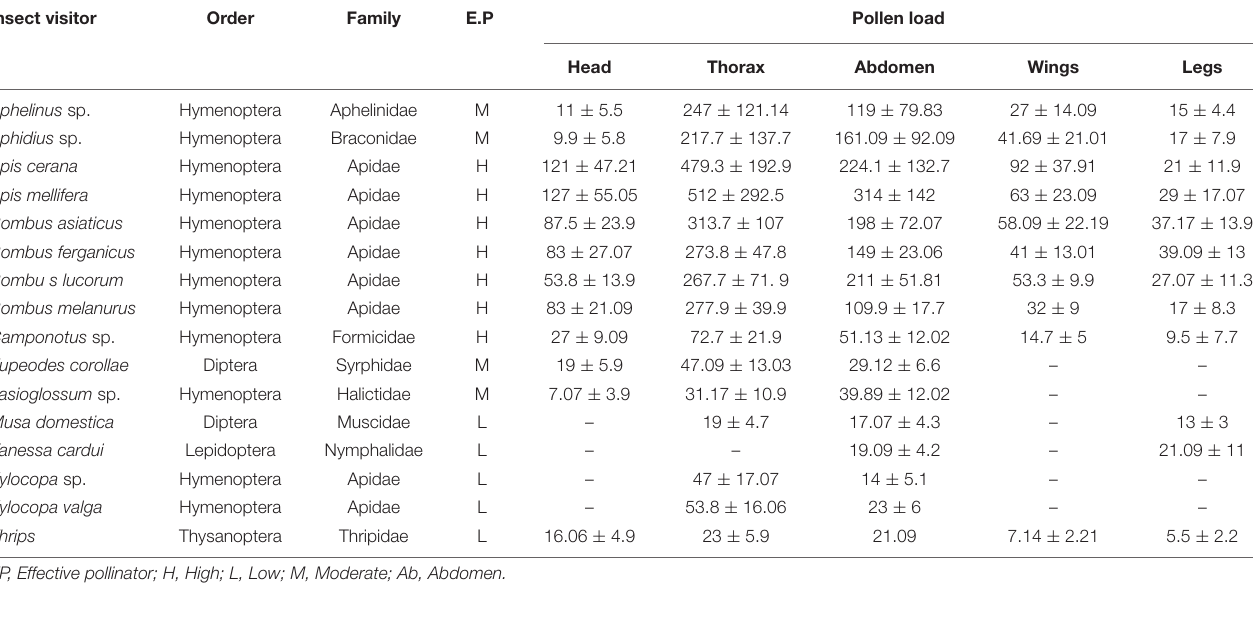
TABLE 8 | Pollen load on different body parts of insect visitors.